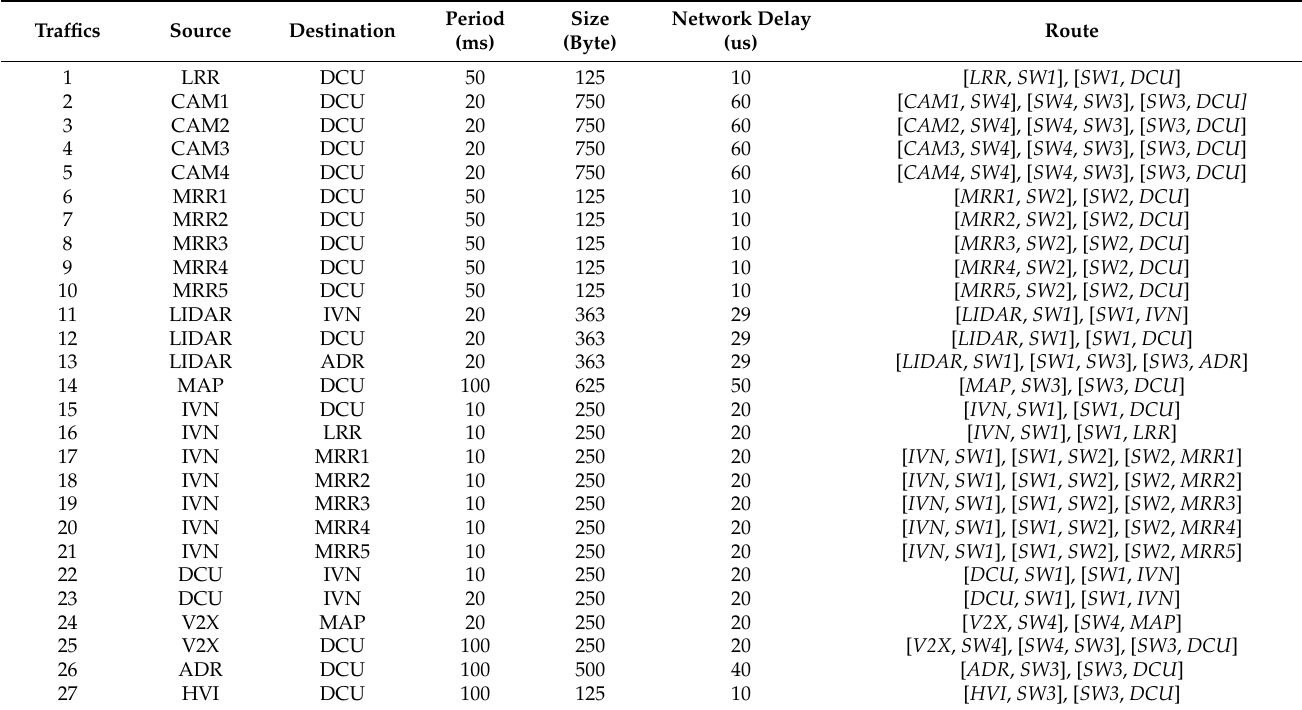
Table 2. Characteristics of flows on the network.